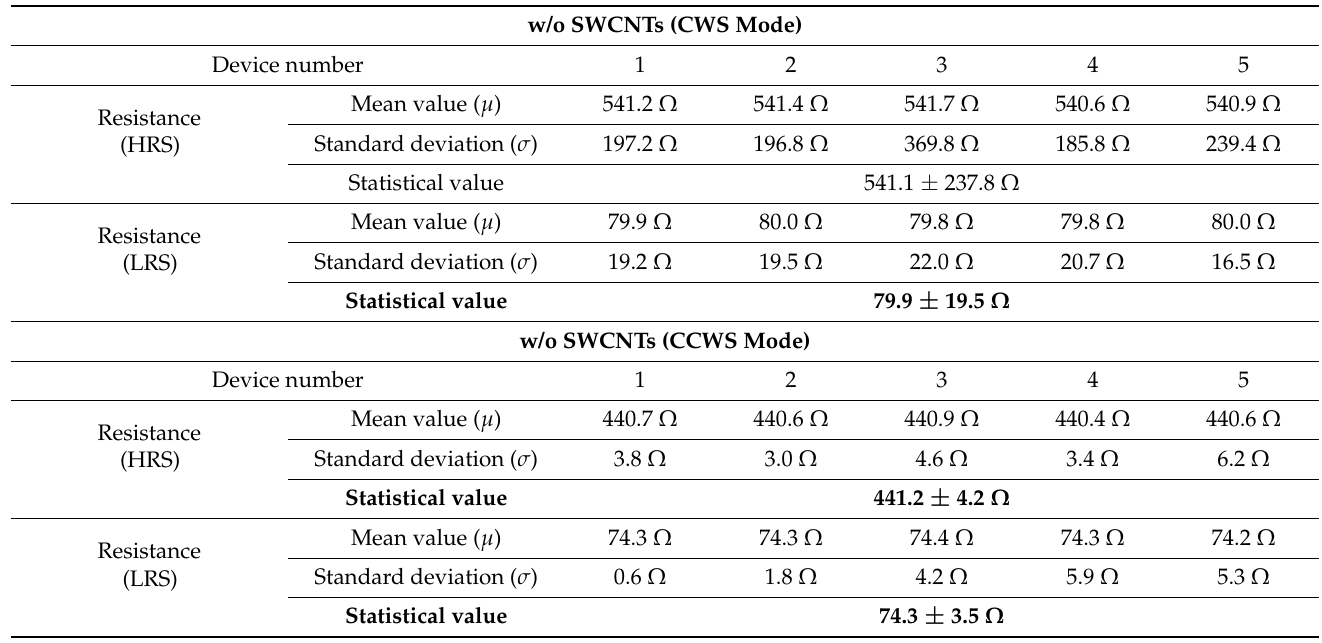
Table 1. Summary of the statistical resistance values in five HSQ memristors w/o the embedded SWCNT random network. w/o SWCNTs (CWS Mode)